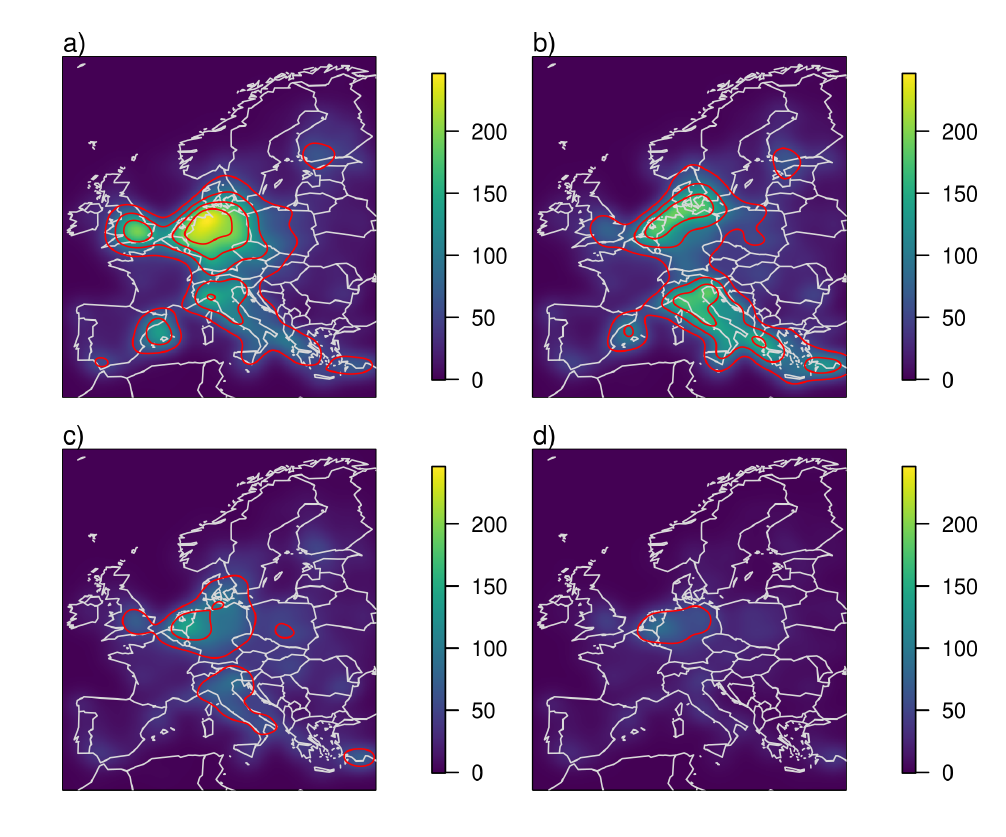
Figure 3. Kernel smoothed ESWD tornado reports per 100 years and 10,000 km 2 based on ( a ) all recorded tornadoes, ( b ) tornadoes recorded in the period 2005–2019, ( c ) tornadoes recorded in the period 2005–2019 that touched land and ( d ) tornadoes recorded in the period 2005–2019 that touched land and have an intensity rating. Contour lines of 50, 100, 150 and 200 reports per 100 years and 10,000 km 2 are drawn in